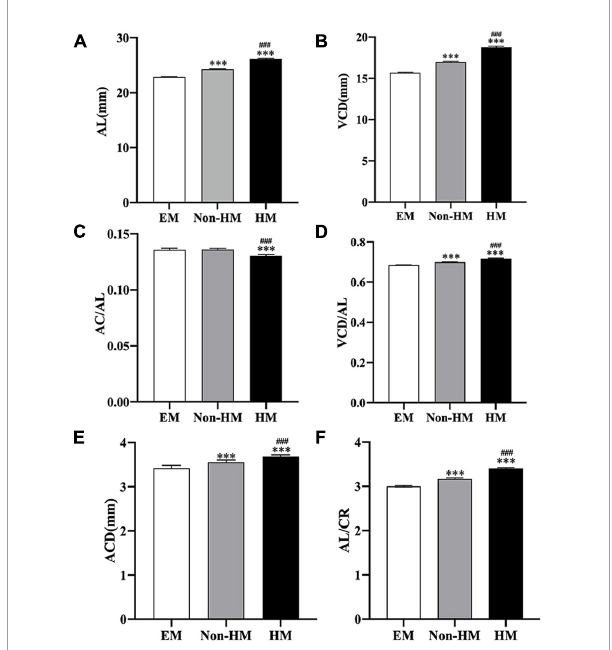
FIGURE3 Ocular biometric parameters of the right eye measured by A-scan and IOL-Master. (A) AL in three groups. (B) VCD in three groups. (C) AC/AL in three groups. (D) VCD/AL in three groups. (E) ACD in three groups. (F) AL/CR in three groups. ∗∗∗ p < 0.001, compared with EM group; ### p < 0.001, compared with non-HM group. EM, emmetropia; HM, high myopia; AL, axial length; VCD, vitreous chamber depth; AC, anterior chamber depth; ACD, anterior chamber depth; CR, radius of corneal curvature.